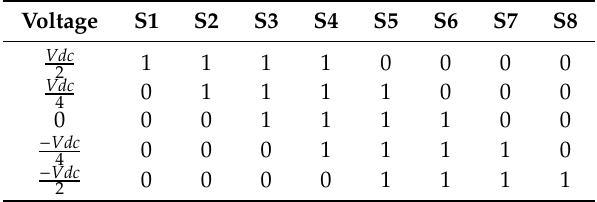
Figure 5. ( a ) Power circuit of 5-level DC-MLI; ( b ) control circuit of 5-level DC-MLI; ( c ) phase output voltage waveform of 5-level DC-MLI. Table 2. 5-Voltage levels of DC-MLI and switching states.